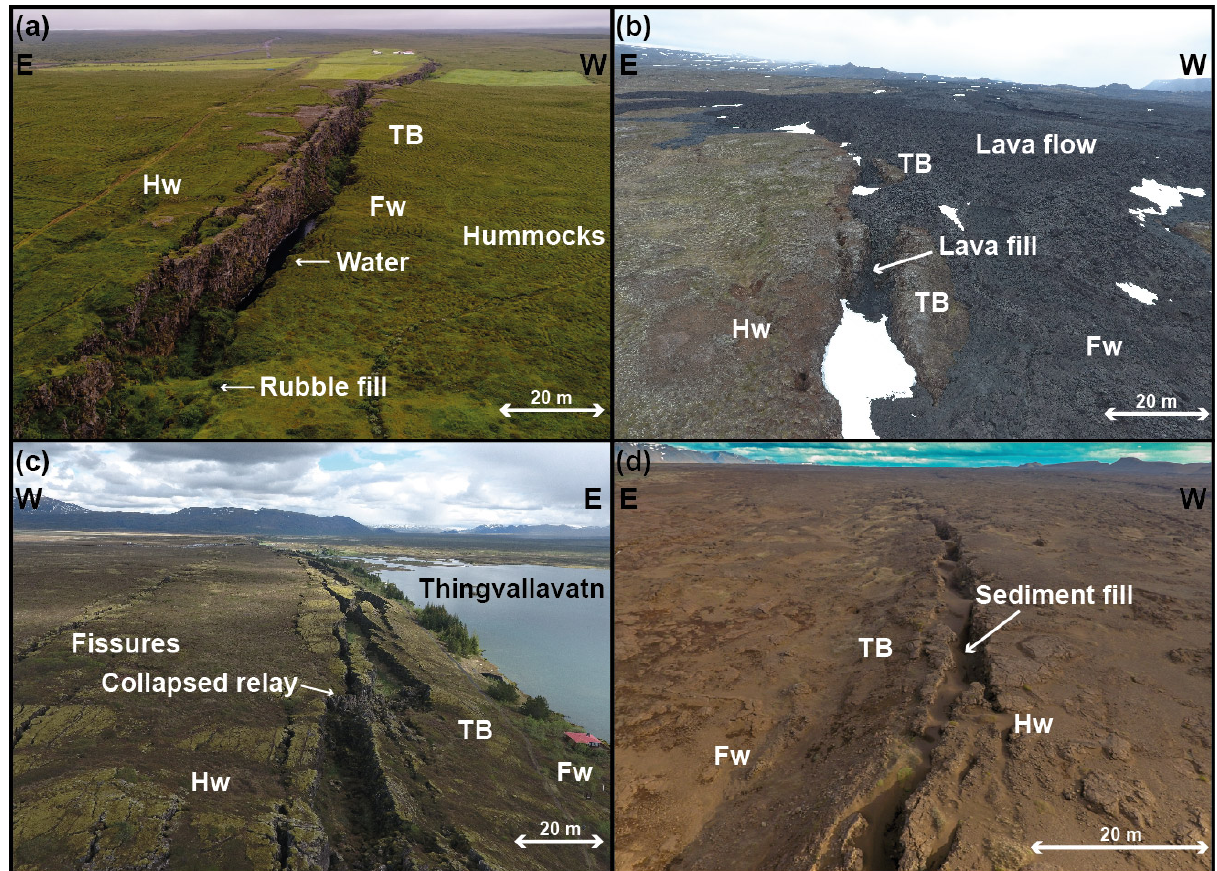
Figure 1. (a) MDF close to the Ásbyrgi canyon in Kelduhverfi (cf. Hatton et al., 1994). Along this fault segment, opening widths reach up to 20m and vertical offsets up to approximately 15m of displacement. Hw: hanging wall, Fw: footwall, TB: tilted block; 66 ◦ 2 (cid:48) 14 (cid:48)(cid:48) N, 16 ◦ 34 (cid:48) 15 (cid:48)(cid:48) W. (b) MDF of the Krafla fissure swarm. The hanging wall has been covered by a lava flow from the Krafla fires, also surrounding the tilted blocks; 65 ◦ 48 (cid:48) 44 (cid:48)(cid:48) N, 16 ◦ 44 (cid:48) 32 (cid:48)(cid:48) W. (c) Southern part of the Almannagjá fault in Thingvellir. A prominent tilted block is dipping eastwards and fault segments are linked by a collapsed relay; 64 ◦ 14 (cid:48) 42 (cid:48)(cid:48) N, 21 ◦ 8 (cid:48) 30 (cid:48)(cid:48) W. (d) Fault segment of the Theistareykir fissure swarm. The opening of the dilatant fault (footwall in the west) with an eastward-dipping tilted block is being filled by sands and aeolian sediments; 65 ◦ 50 (cid:48) 50.38 (cid:48)(cid:48) N, 17 ◦ 0 (cid:48) 20 (cid:48)(cid:48)